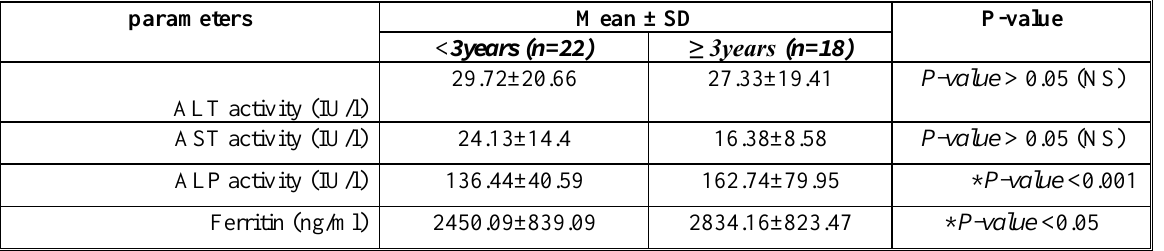
Table4. Effect of Age on Serum ALT, AST, ALP and Ferritin in Group B.